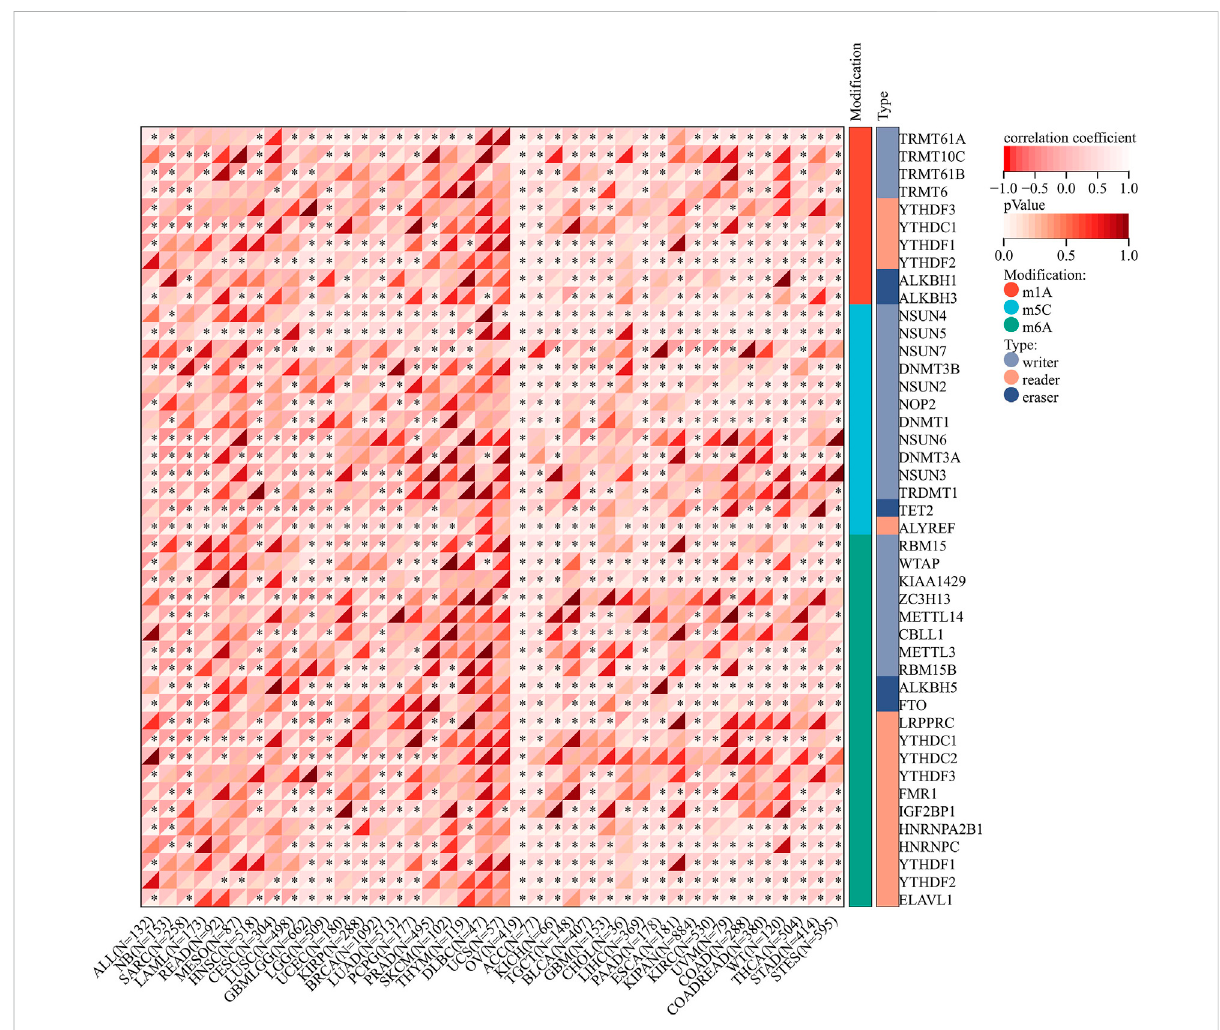
FIGURE 11 Analysis of correlation between the expression of AGTRAP and RNA modi fi cation